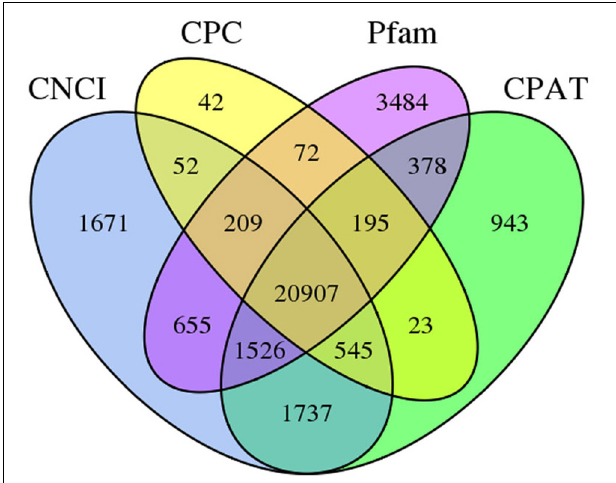
FIGURE 3 | Venn graph of lncRNA transcripts from CPAT, CNCI, CPC, and Pfam analyses.